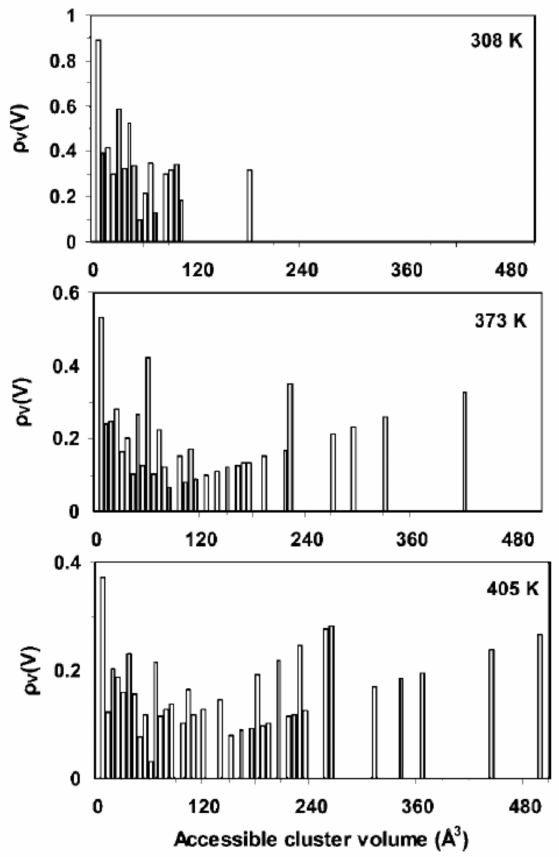
Figure 10. For a solute radius of 2.1 Å, volume-weighted distribution of free volume for a CO 2 – polystyrene system with a concentration of 35 cm 3 (STP) CO 2 /cm 3 pol at 308, 373, and 405 K (used with copyright permission)